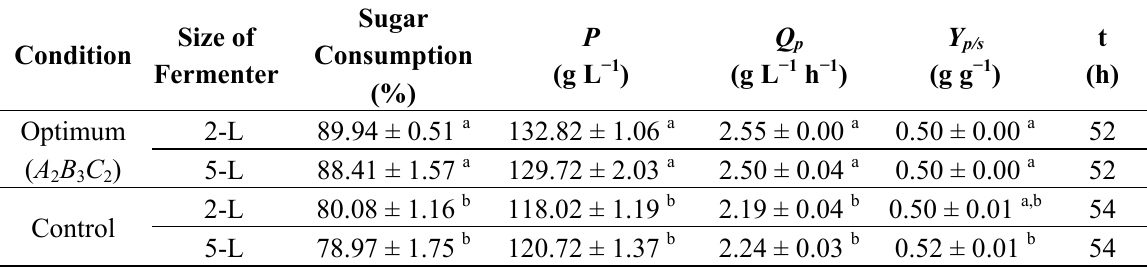
Table 7. Main fermentation parameters of batch ethanol production from the sweet sorghum juice under the optimum and control